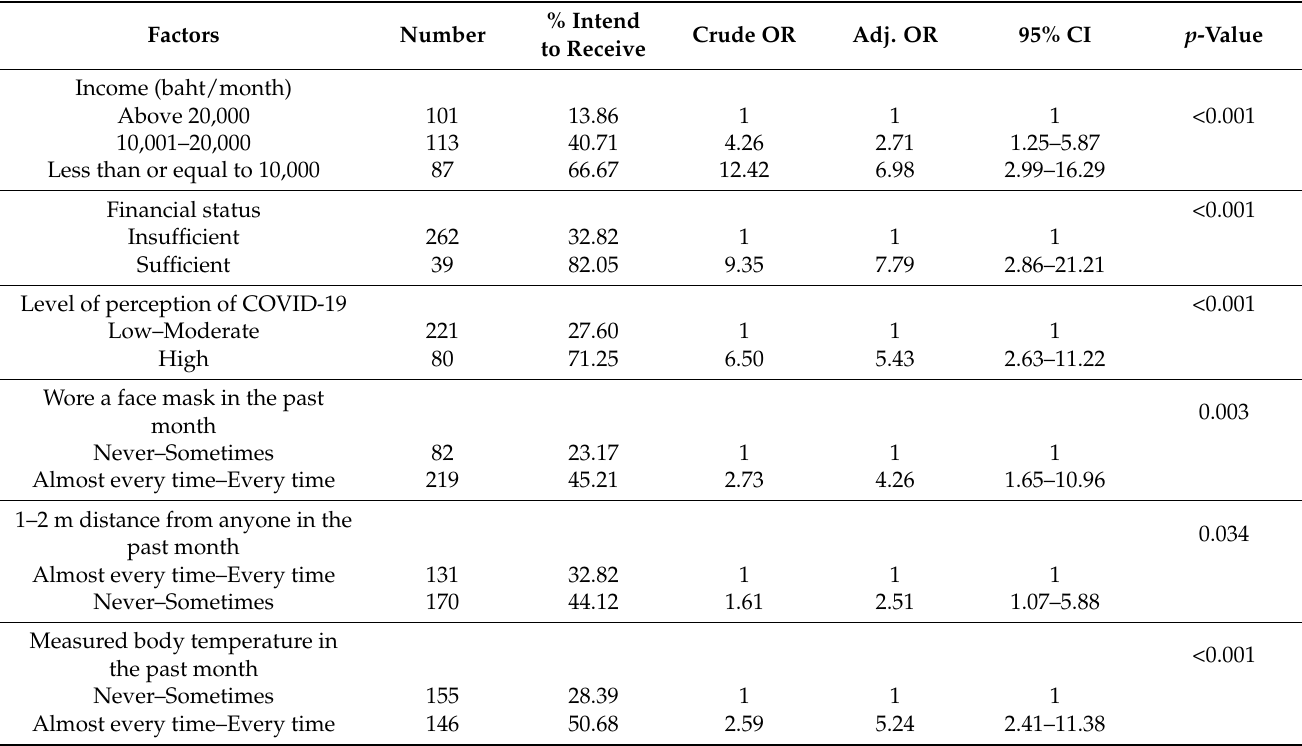
Table 5. Unadjusted and adjusted logistic regression analyses of factors associated with the acceptance of the COVID-19 vaccine ( n =